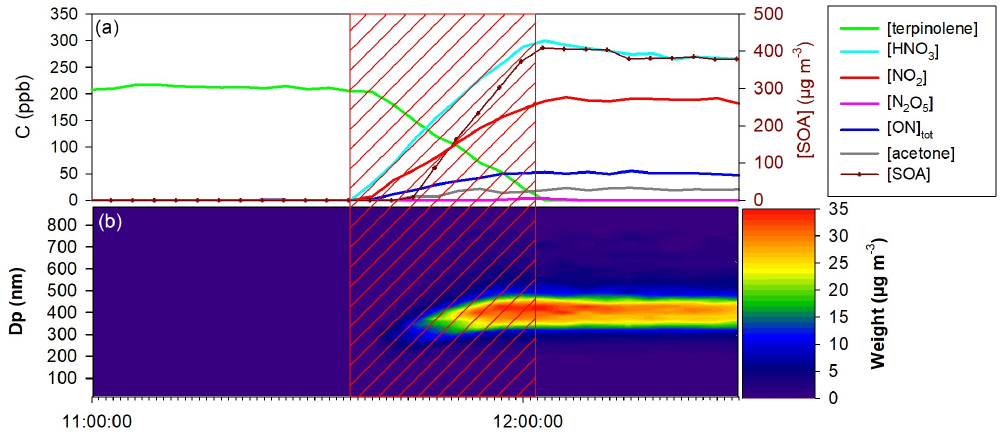
Figure 4. Dilution-corrected time-dependent concentration of gaseous species, aerosol mass, SOA size distribution during a typical ex- periment of NO 3 -initiated oxidation of terpinolene (18 December 2017). The hatched red area corresponds to the N 2 O 5 injection period. (a) Terpinolene, N 2 O 5 , NO 2 , HNO 3 , acetone and total ONs from FTIR and SOA mass concentration from the SMPS; (b) SOA size distri- bution in mass concentration from the SMPS. The time zone of the time scale is UTC + 1.